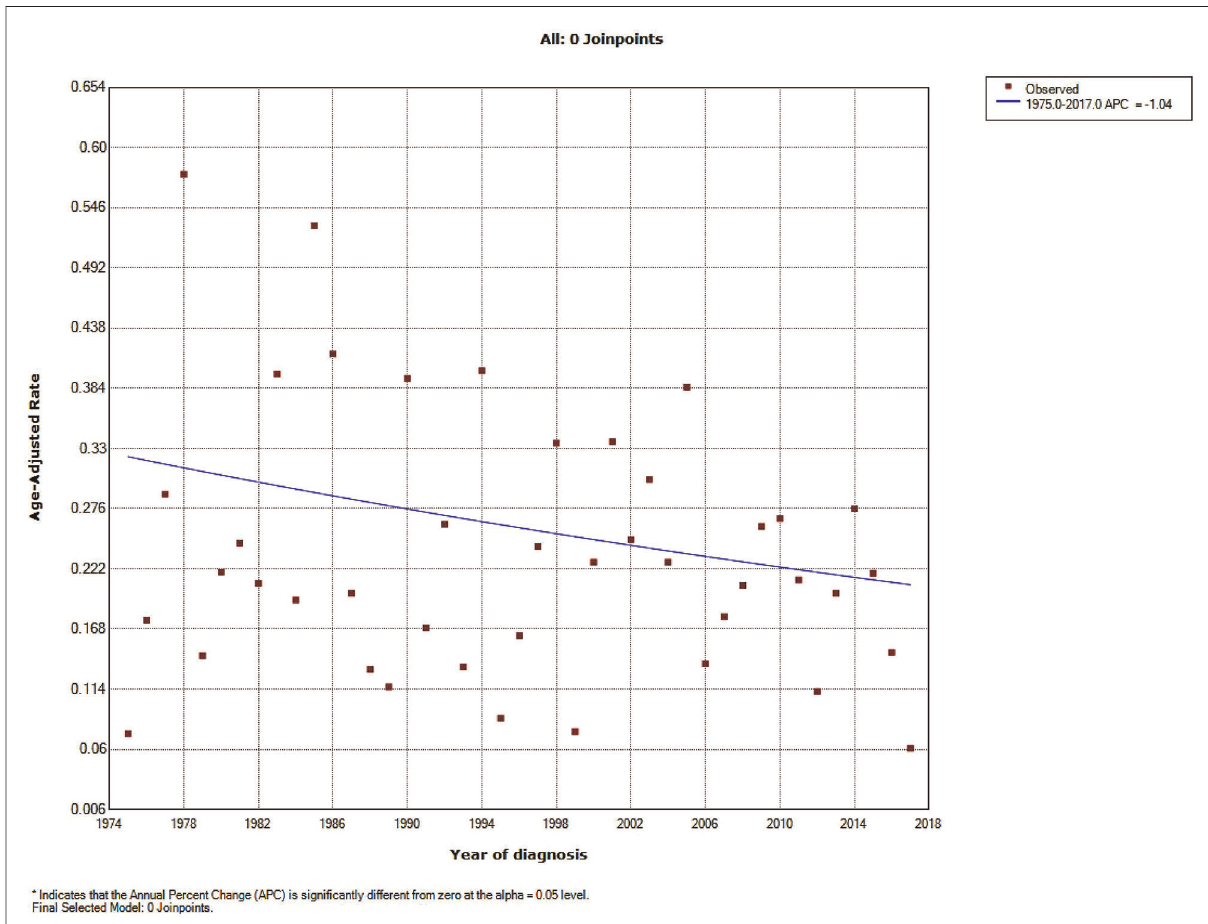
FIGURE 1 Incidence trend over years in patients with primary malignant pituitary tumor from the SEER research data with nine registries (1975 –